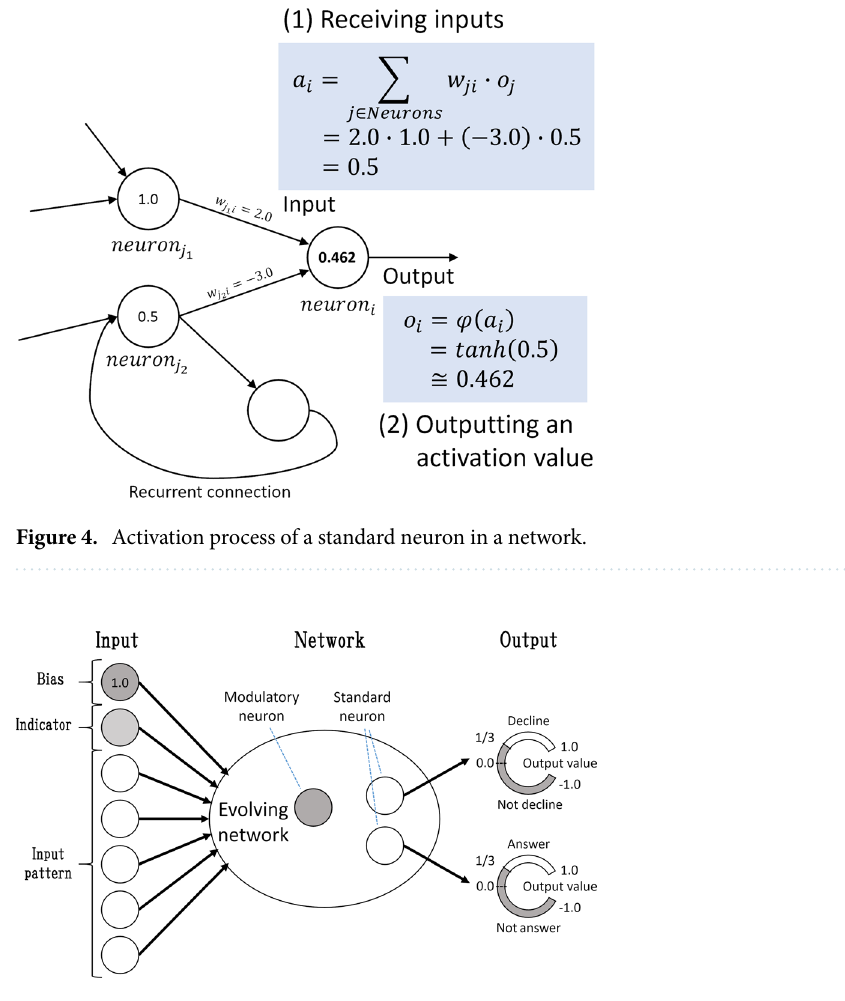
Figure 5. Inputs and outputs of a neural